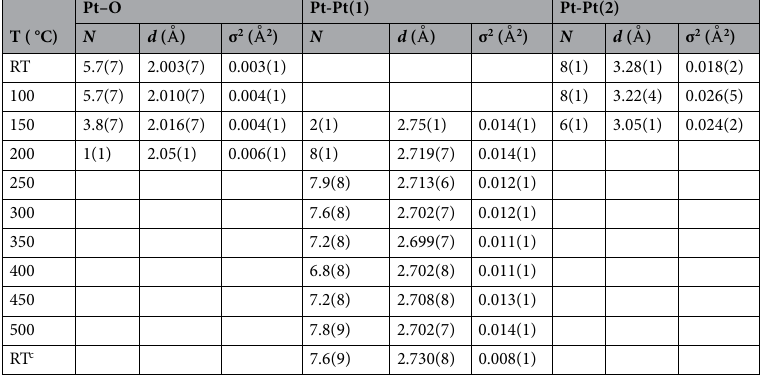
Table 2. Fit results of EXAFS data of H 2 O 2 -Pt/Ti–FS at the Pt L 3 edge. Data are shown in Fig.